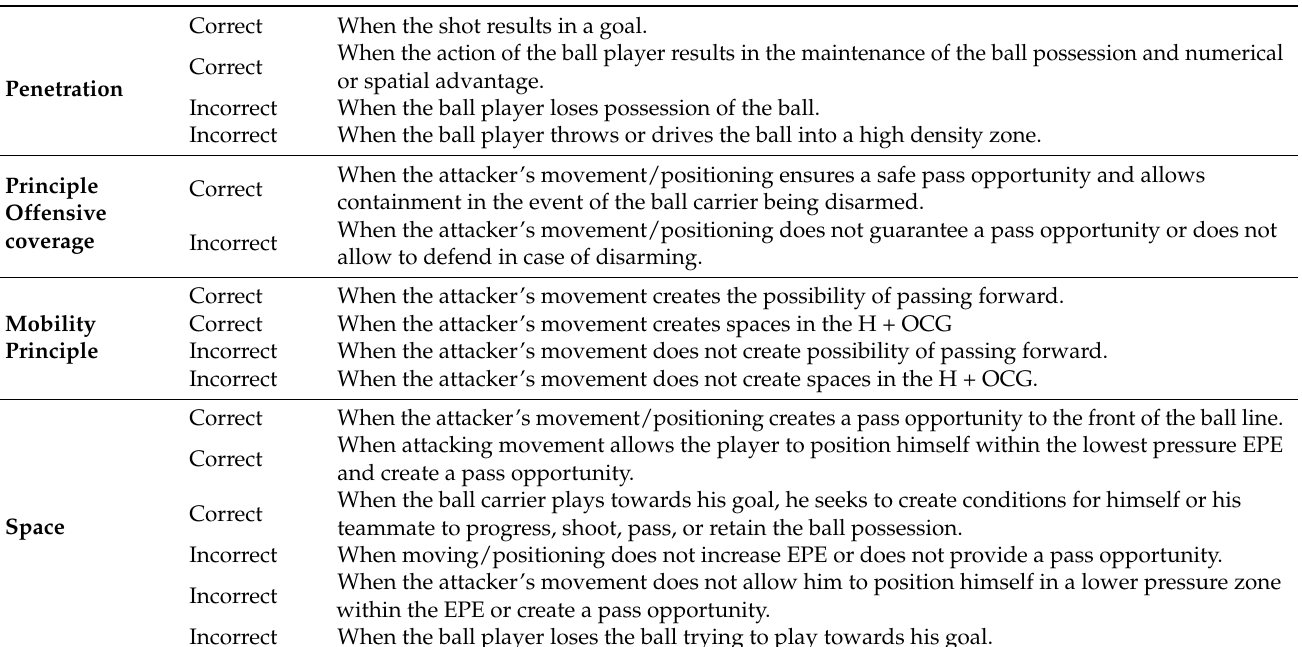
Table 4. Classification of motor effectiveness regarding performance indicators as correct and incorrect for specific offensive game principles.